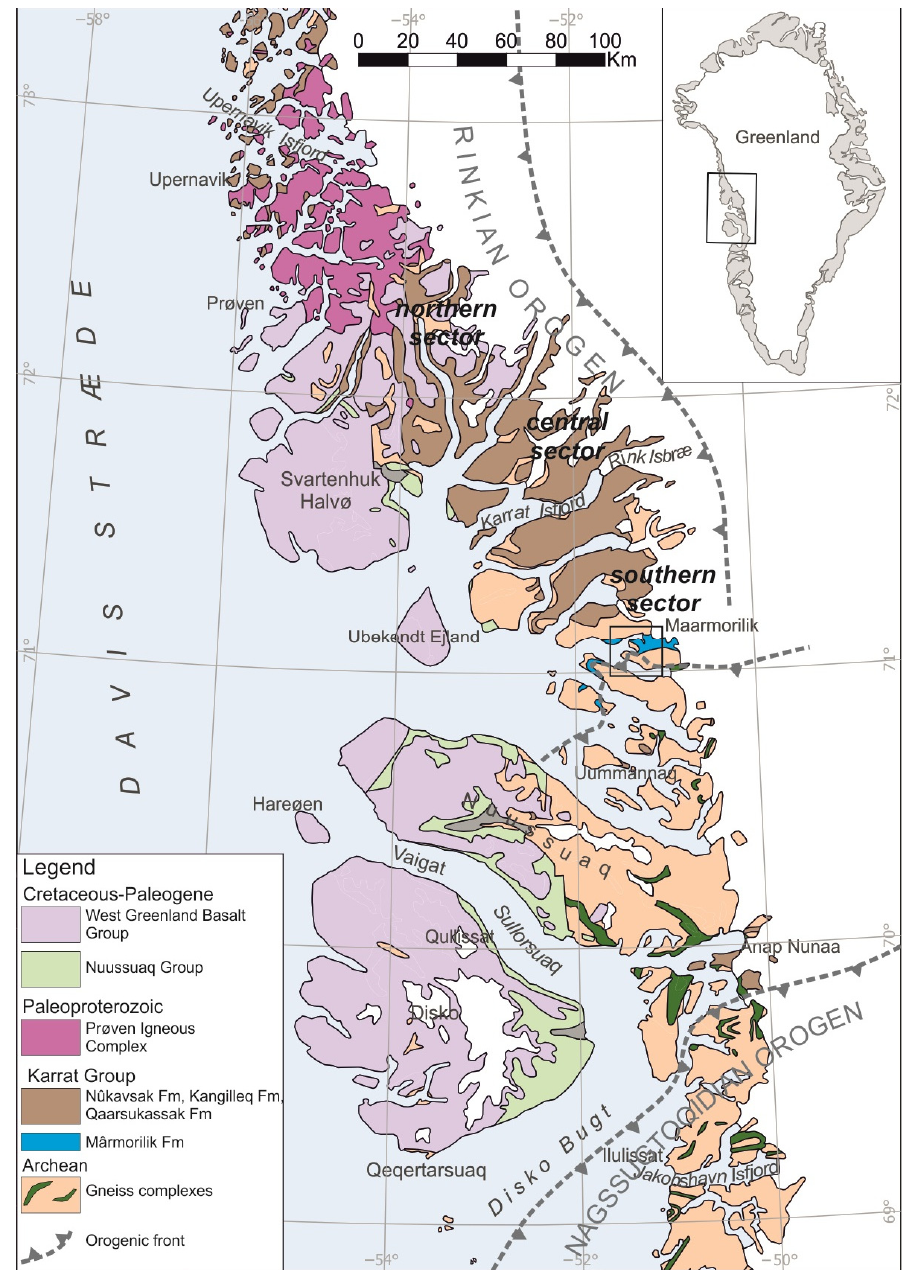
Figure 1. Geological map of West Greenland showing the extension of the Rinkian Orogen and the frontal part of the Nagssugtoqidian Orogen (modified after [8]). Black box indicates Figure 2.